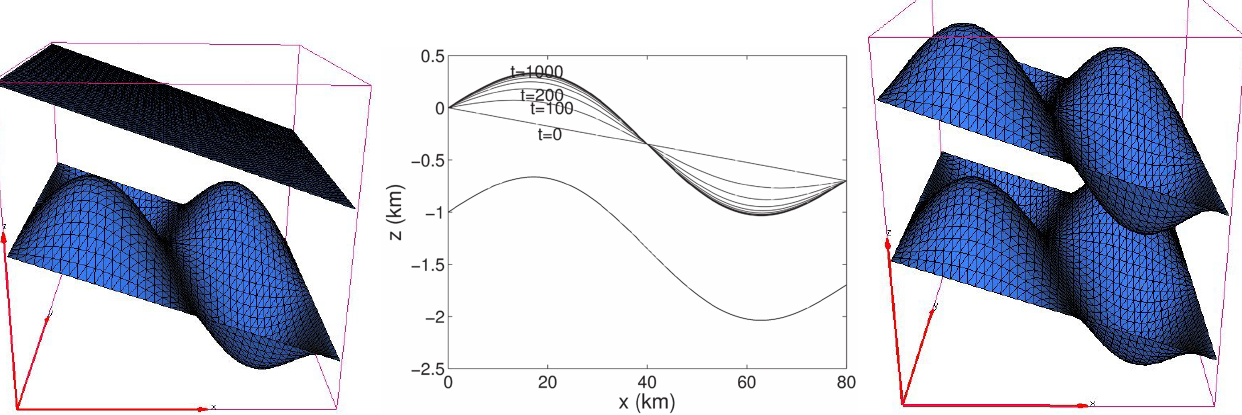
Fig. 1. Illustration of the ice-sheet geometry (the top and bottom surfaces) at the time t = 0 (left) and at the time t = 1000yr (right). The middle figure is the x -direction profiles taken at y = L/ 4 of the ice-sheet top and bottom surfaces at 100 year time intervals from t = 0 to